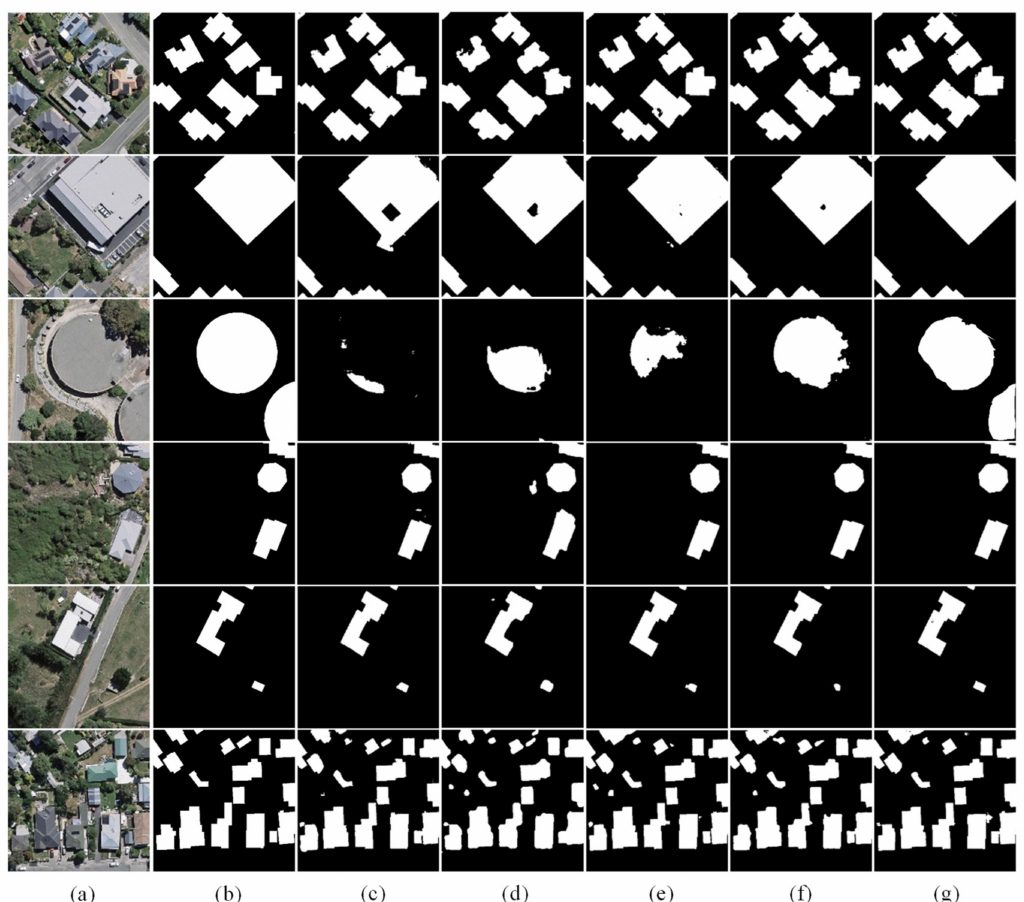
Figure 11. Results of building footprint segmentation on the RSIBE dataset. ( a ) Images. ( b ) Labels. ( c ) U-Net. ( d ) PSPNet. ( e ) DeepLabV3+. ( f ) HRNet. ( g ) MultiBuildNet.